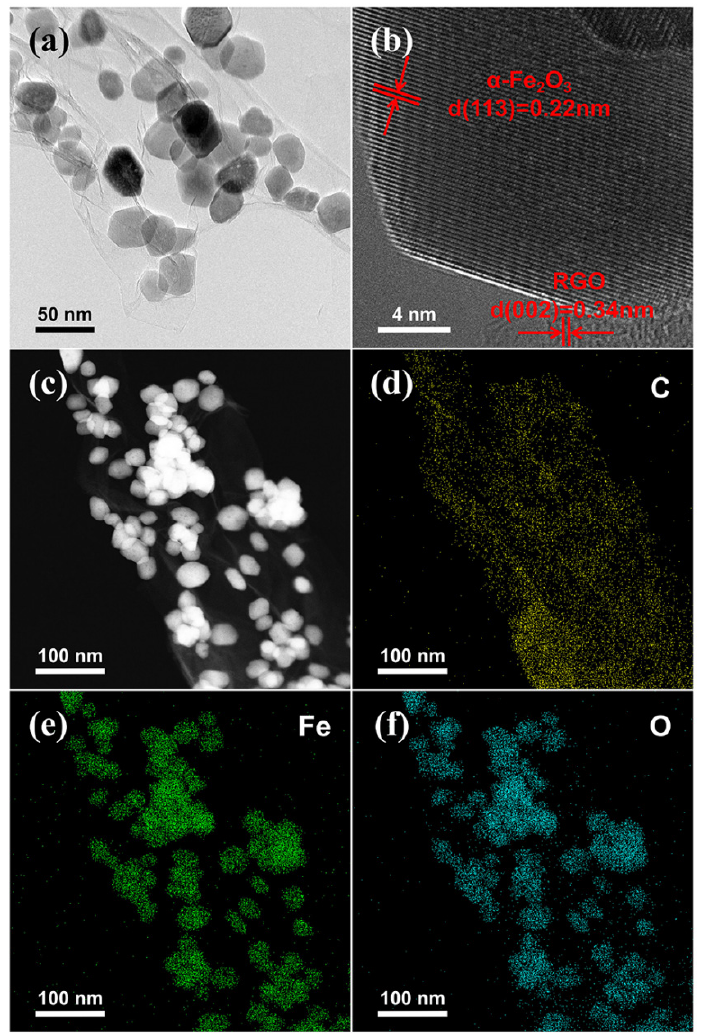
Figure 3. ( a ) TEM images of large-area and ( b ) high-resolution TEM image of α -Fe 2 O 3 /RGO composites; ( c – f ) EDS elemental mapping images of α -Fe 2 O 3 /RGO composites.